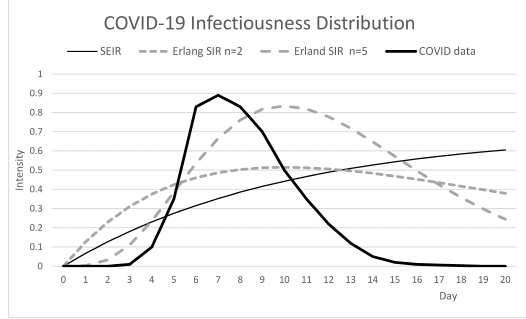
Figure 1. Dependence of infectivity on the time-since-infection for COVID-19 clinical data (bold black line), SEIR distribution, and Erlang distribution [19].